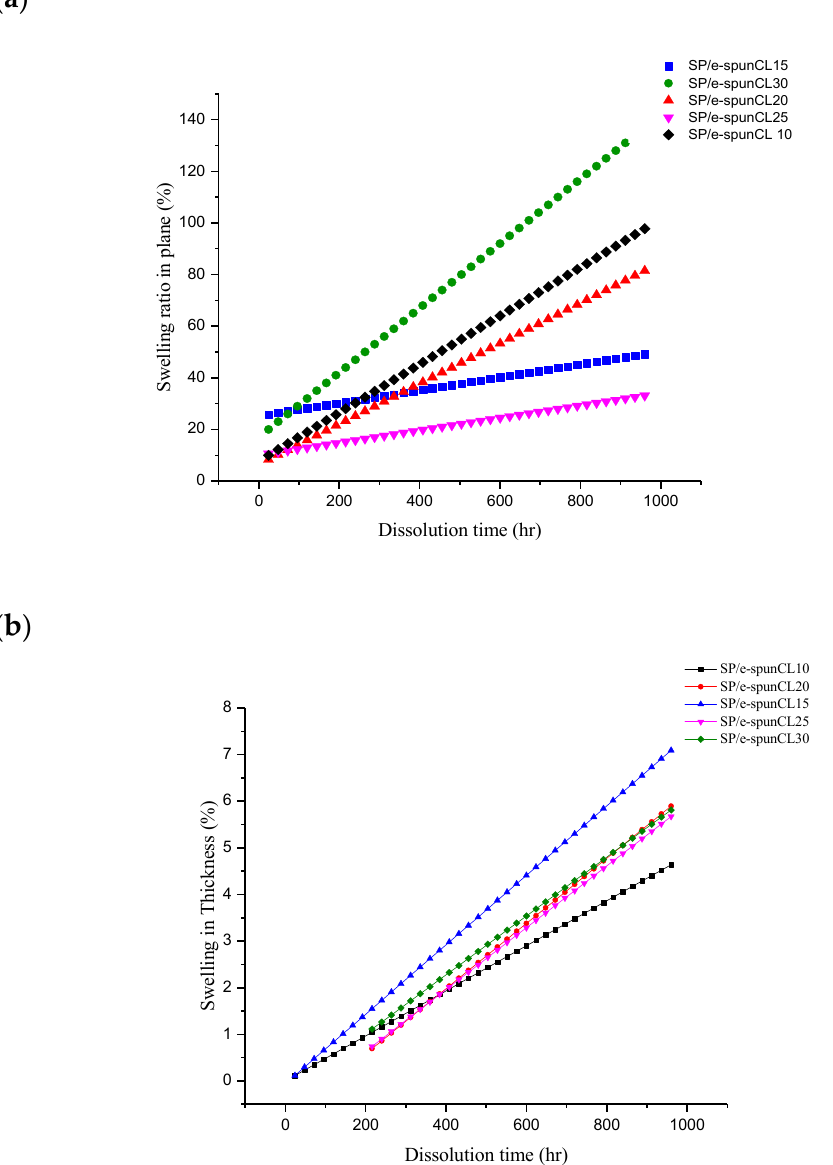
Figure 9. Swelling ratios in ( a ) plane and ( b ) thickness of SP/e-spunCL nanocomposite